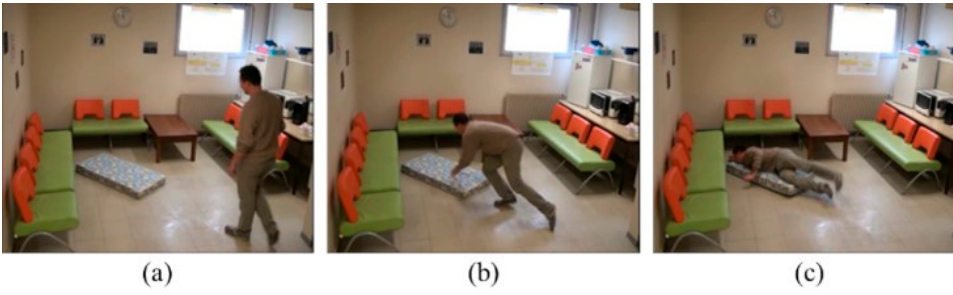
Figure 1. Human fall incident: ( a ) standing, ( b ) falling, ( c ) fallen.